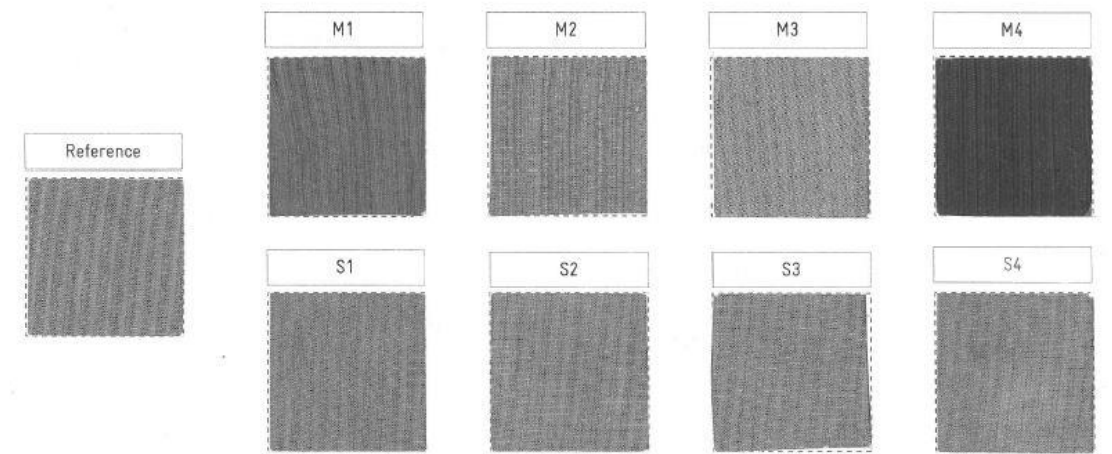
Figure 5. Aspects of 30-times-washed-electrode of each lot for Yarn A.